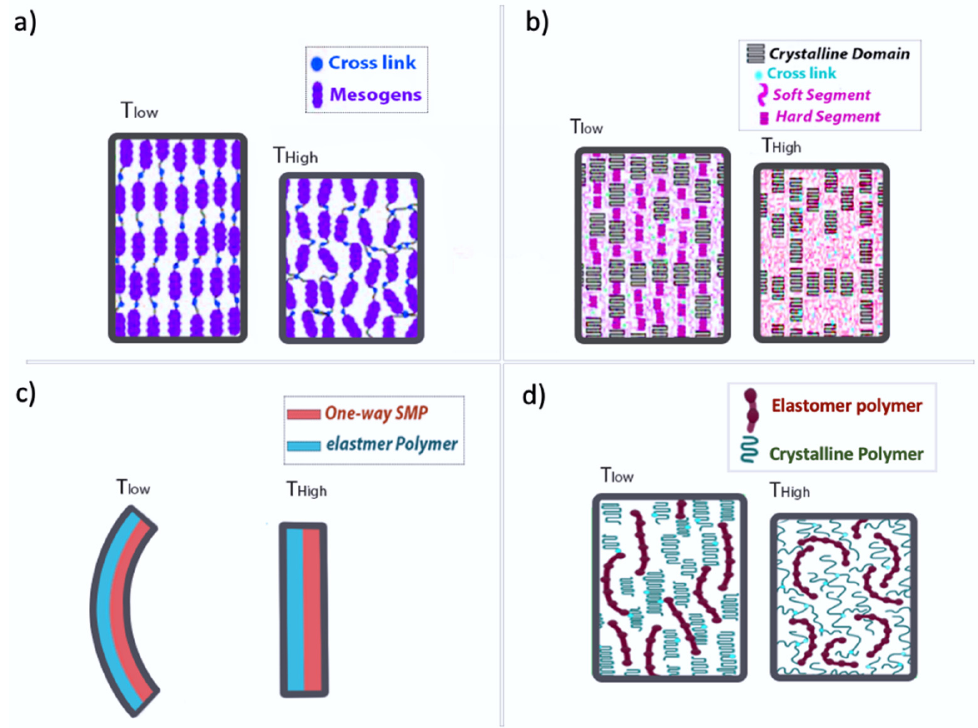
Figure 3. Schematic of the strategies for thermally induced two-way SMPs: ( a ) liquid crystalline elastomer; ( b ) semi crystalline network; ( c ) polymeric composite network, ( d ) interpenetrating network.